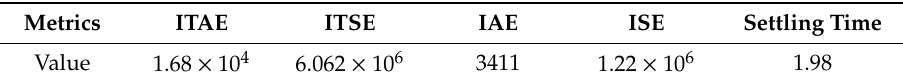
Table 13. Results for the PID controller.